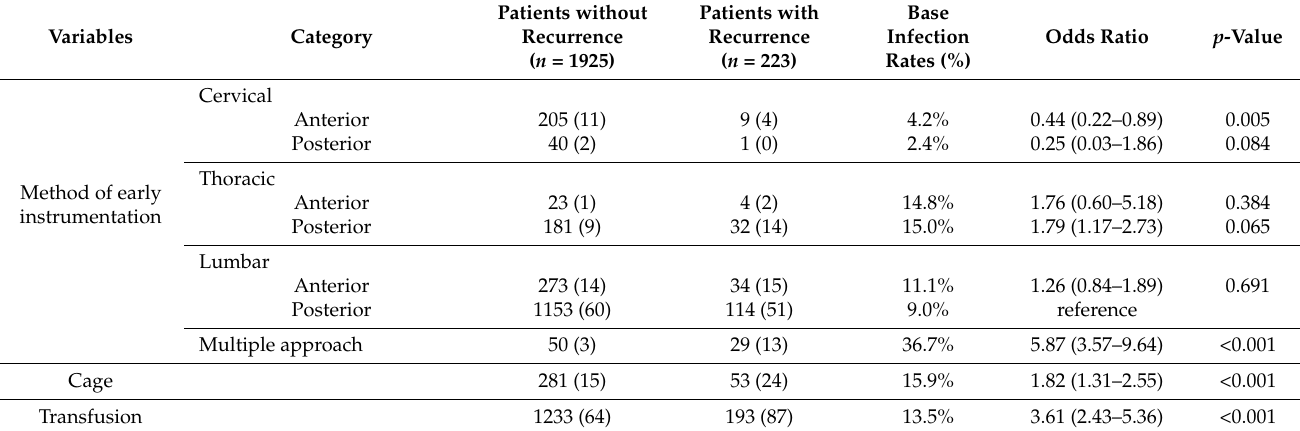
Table 3. Comparison of surgical profiles during the index surgery.